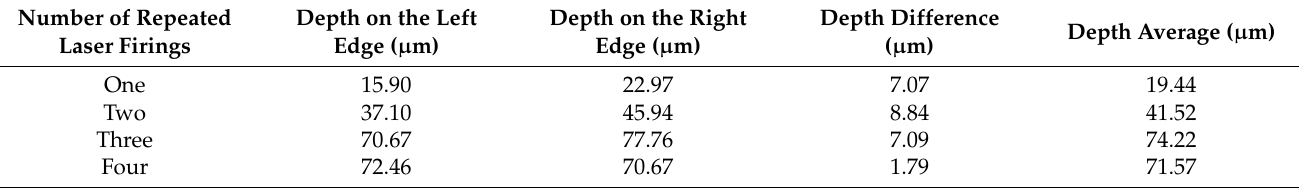
Table 6. The measured depth values after different numbers of repeated laser firings with the 4w_30k_300_re20 recipe. Number of Repeated Laser Firings